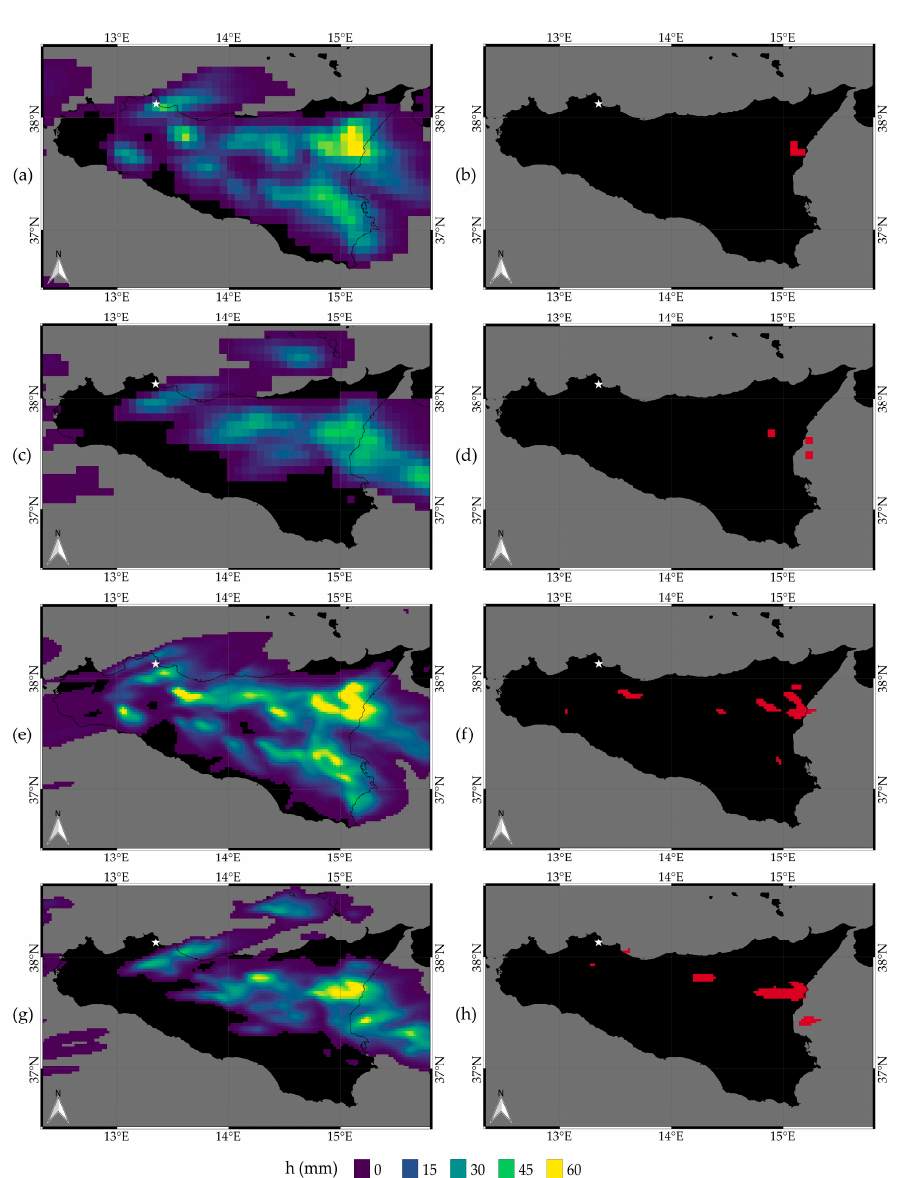
Figure 7. The maps show: 48 h rainfall forecasts ( a ) and heavy rainfall alerts ( b ) provided by the 00 UTC model run on 14 July at 7.5 km resolution; 24 h rainfall forecasts ( c ) and heavy rainfall alerts ( d ) provided by the 00 UTC model run on 15 July at 7.5 km resolution; 48 h rainfall forecasts ( e ) and heavy rainfall alerts ( f ) provided by the 00 UTC model run on 14 July at 2.5 km resolution; 24 h rainfall forecasts ( g ) and heavy rainfall alerts ( h ) provided by the 00 UTC model run on the 15 July at 2.5 km resolution. The white star represents the position of